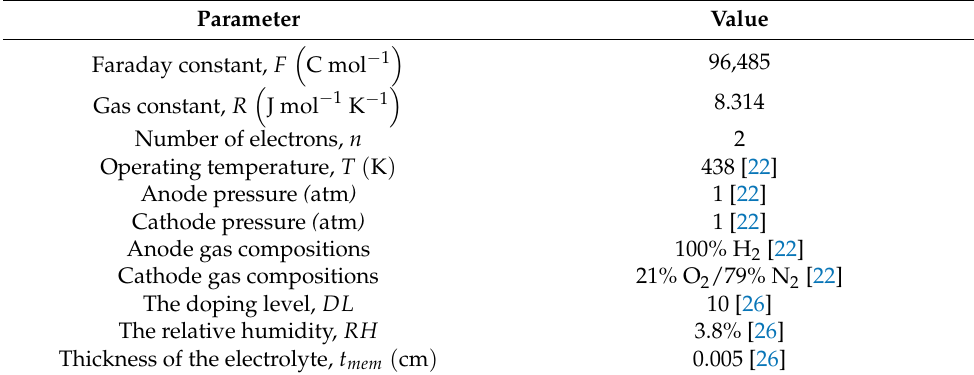
Table 1. Parameters used in the